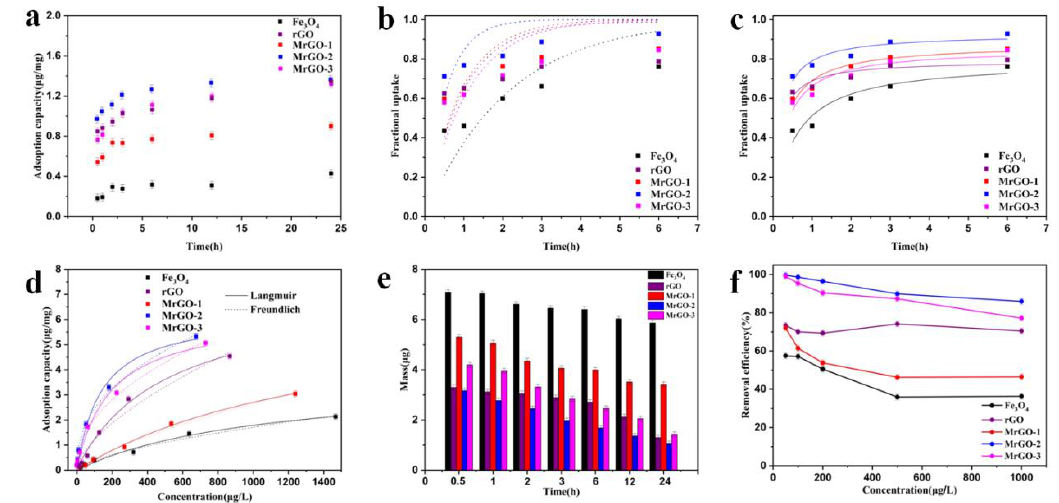
Figure 6. Adsorption behavior of the five types of magnetic materials: ( a ) adsorption kinetics, ( b ) pseudo-first-order fit for t ≤ 6 h, ( c ) pseudo-second-order fit for t ≤ 6 h, ( d ) adsorption isotherms, ( e ) SDZ mass variation, ( f ) SDZ removal efficiency. Reaction conditions: T 0 = 25 °C, C 0, SDZ = ( a , c ) = 400 μg/L, C 0, SDZ = ( b , d ) = 50–2000 μg/L, (adsorbents) = 0.25 g/L and pH with no adjustment.